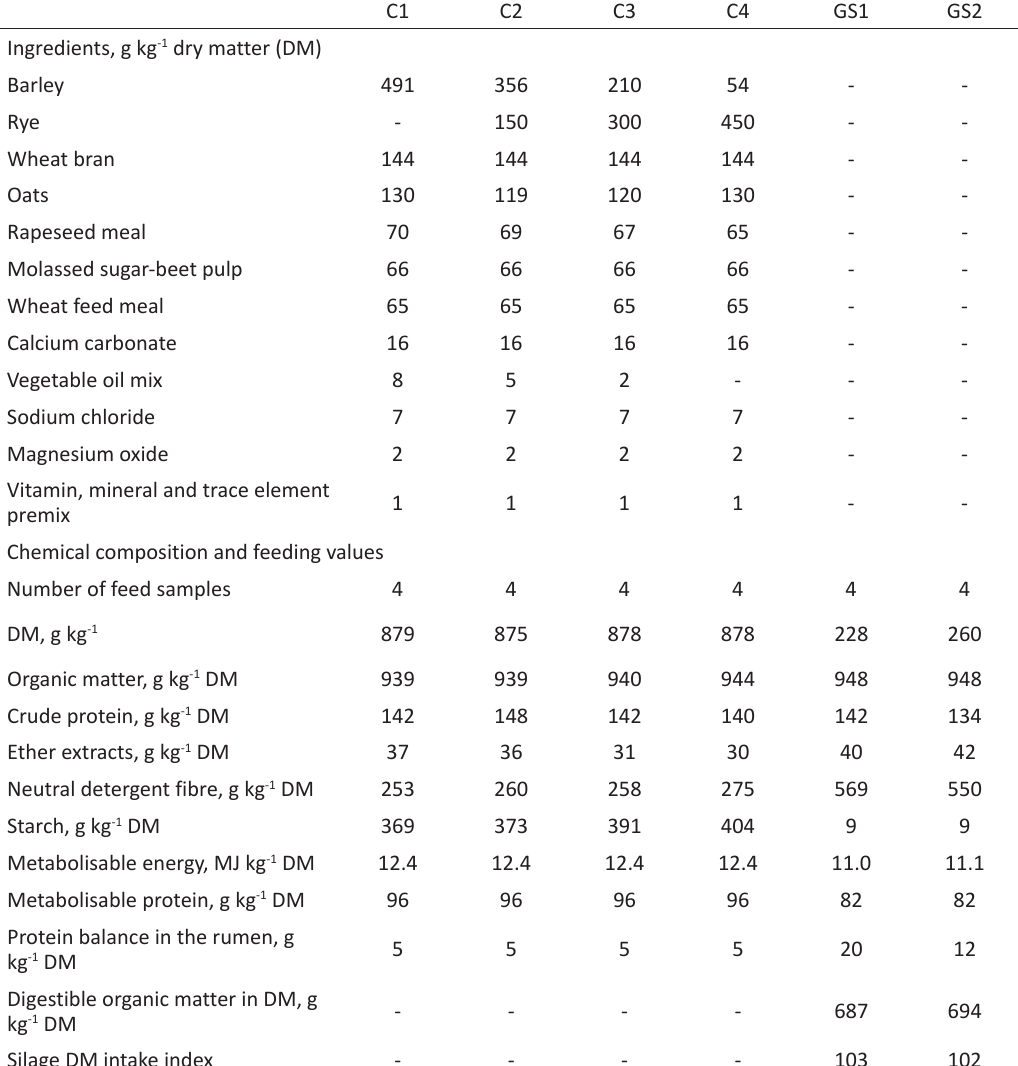
Table 1. Ingredients, chemical composition and feeding values of the four concentrate feeds (C1, C2, C3 and C4) and grass silages (GS1 = primary growth, GS2 = regrowth) used in the feeding experiment